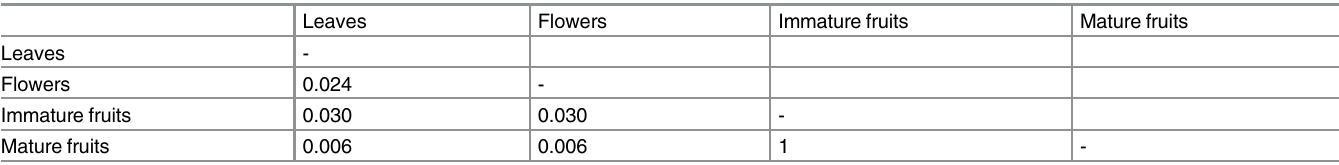
Table 2. Comparison of alpha diversity between strawberry organs based on Shannon index. P values were determined using 999 Monte Carlo per- mutations and were considered significantly different when P was (cid:1) 0.05.